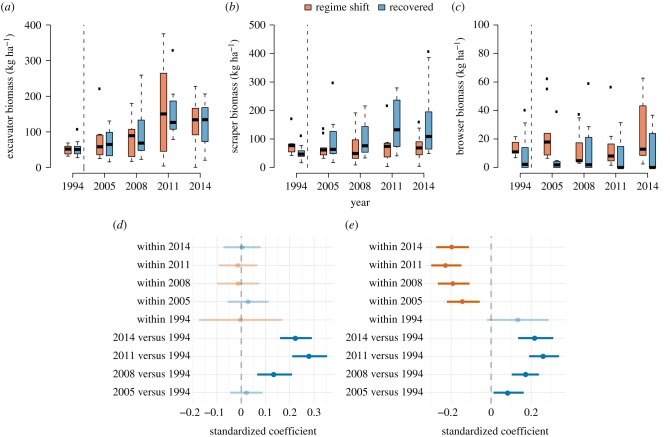
Biomass of parrotfish functional groups. Box (median and 50% quantile) and whisker (95% quantile) plots, and forest plots of model coefficients with 95% CIs of (a,d) excavating parrotfish, (b,e) scraping parrotfish and (c) browsing parrotfish. Reefs are grouped as figure 1. Note different y-axis scales. Vertical dashed lines on panels (a–c) indicate the occurrence of the 1998 bleaching event. No forest plot is presented for browsing parrotfish due to lack of data to construct a linear model.